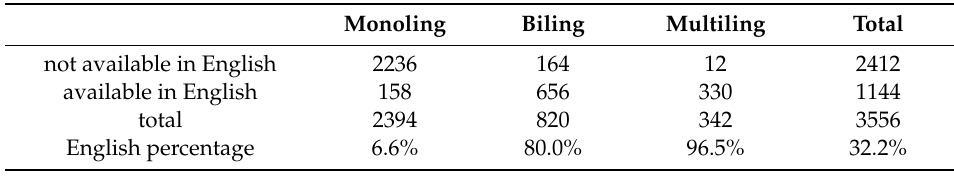
Table A16. English language availability (ee).